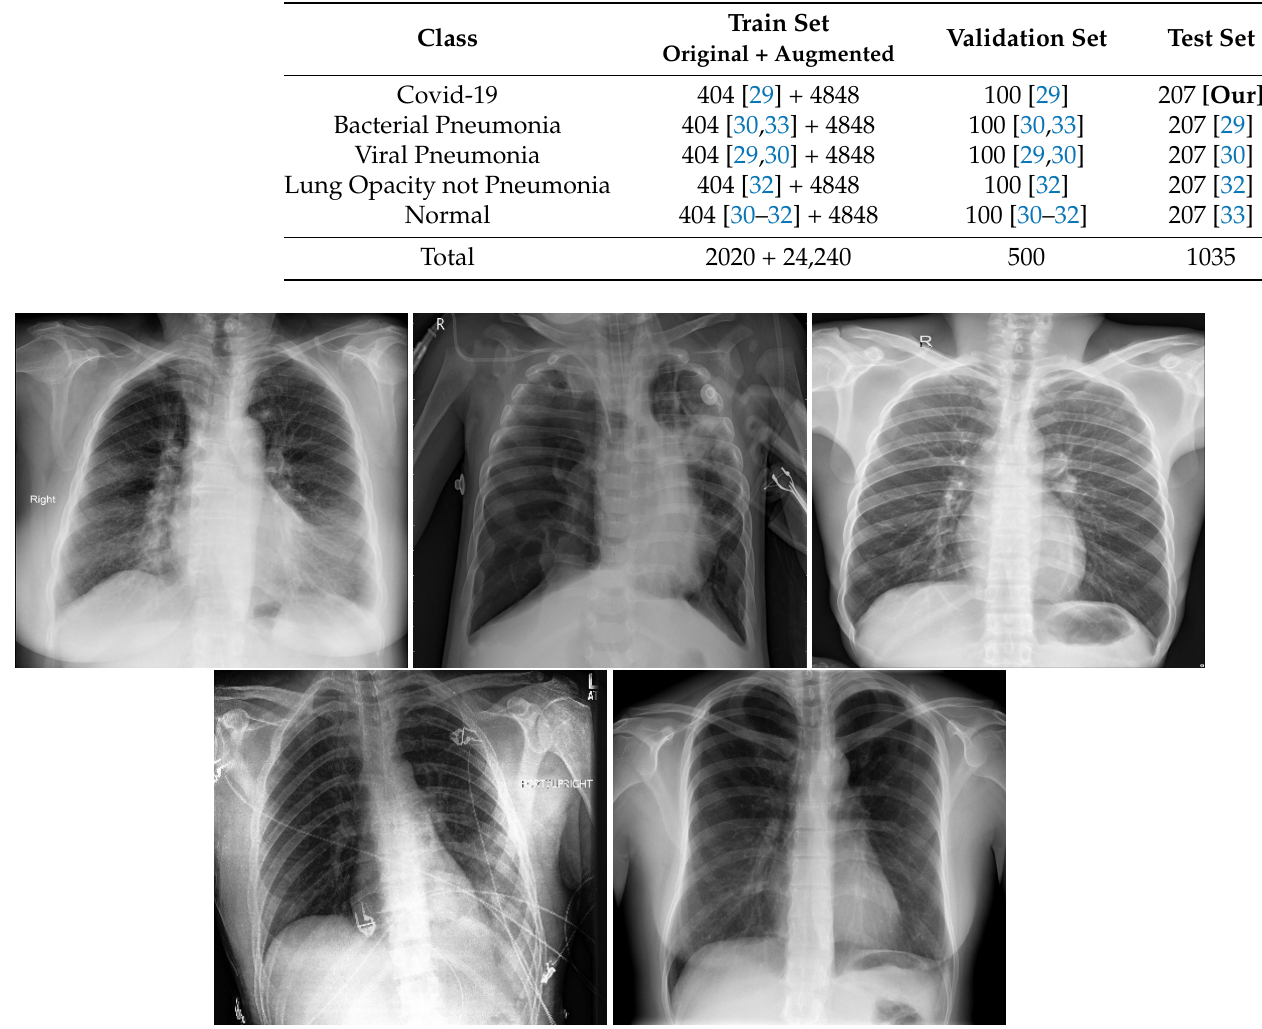
Figure 2. In order: COVID-19, Viral Pneumonia, Bacterial Pneumonia, Lung Opacity,